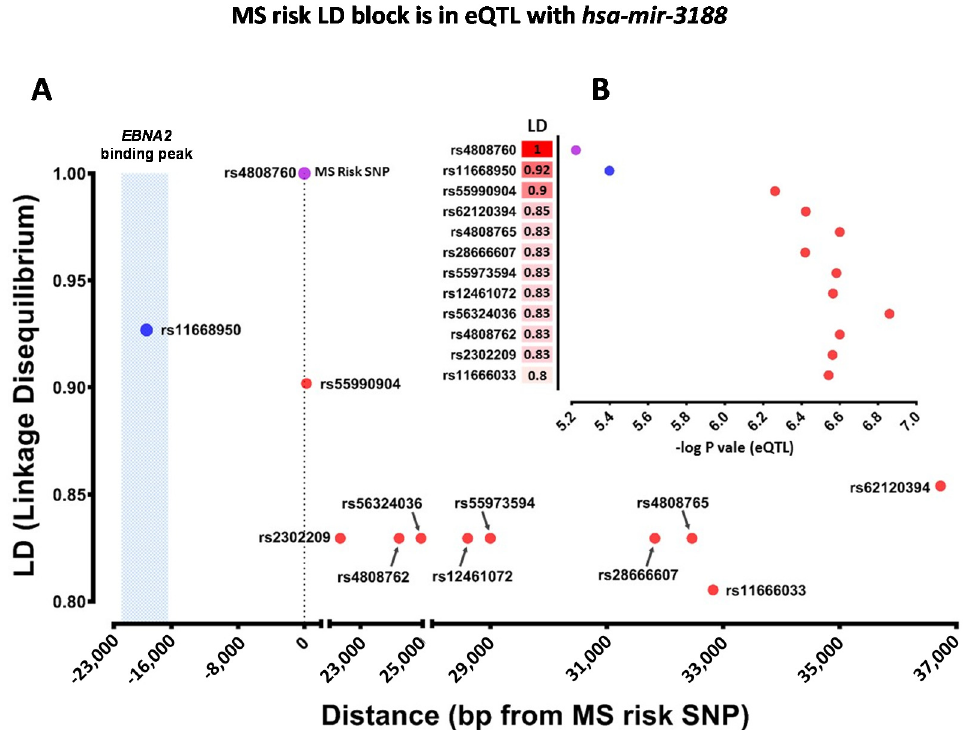
Figure 2. The eQTL effect and architecture of the LD block containing MS risk SNP rs4808760 LD block. rs4808760 is an MS risk SNP which is proximal to hsa-mir-3188-3p . Y and X axes in ( A ) demonstrate LD value and location of each SNP in rs4808760 LD block, respectively. Y and X axes in ( B ) demonstrate LD value and eQTL significance of each SNP in rs4808760 LD block, respectively. Blue circle represents a SNP which is targeted by EBNA2 . The purple circle shows the MS risk SNP. Red circles show the other SNPs in this LD block which are were in eQTL with hsa-mir-3188-3p with FDR less than 5% In the Geuvadis Euro cohort ( n = 373) [PMID: 24037378] of the Geuvadis